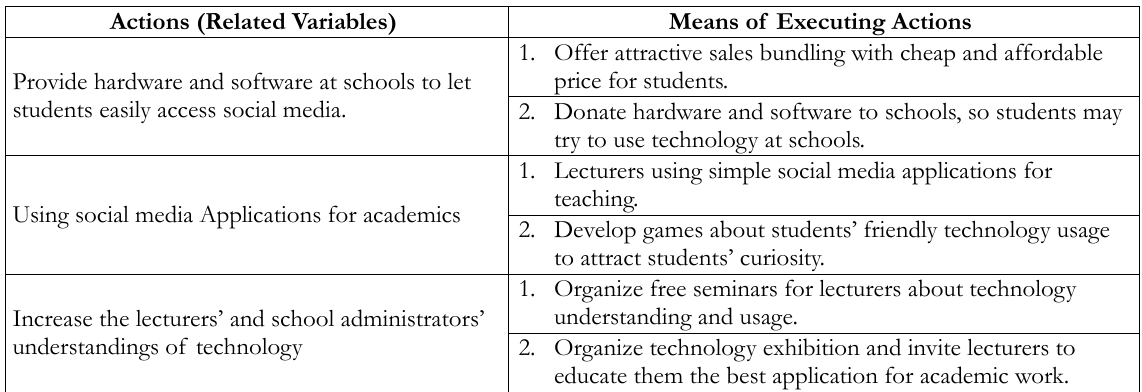
Table 5. Practical Means Associated with Actions in Table 4